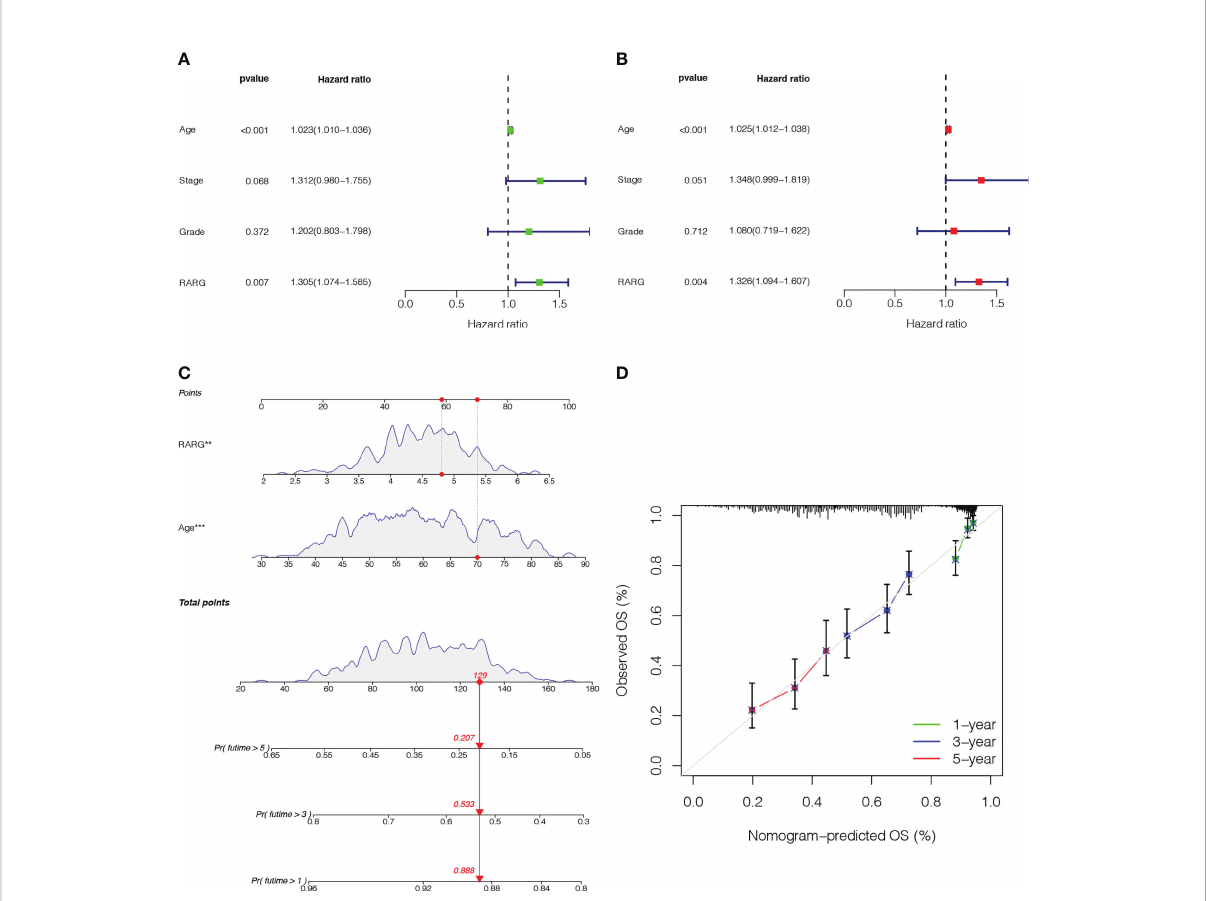
FIGURE 3 Establishment and validation of a nomogram based on the RARG. (A) Univariate Cox regression analysis. (B) Multivariate Cox regression analysis. (C) A nomogram was constructed for predicting the 1-, 3- and 5-year survival rates of OC patients. (D) Calibration curves showed the actual rate versus predicted probability of 1-, 3- and 5-year